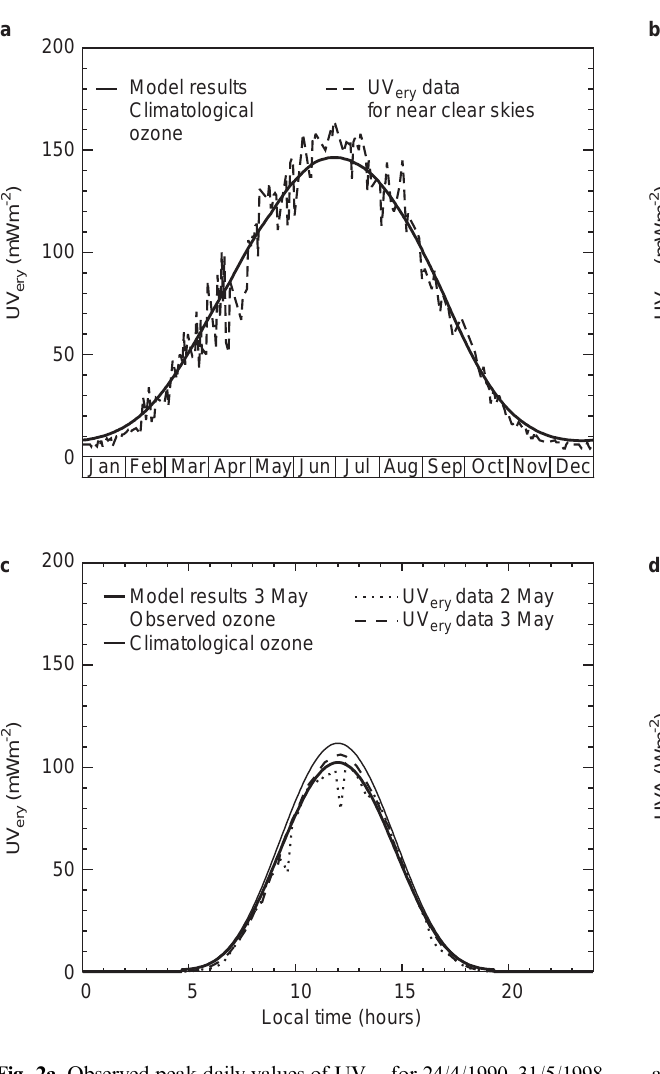
Fig. 2a. Observed peak daily values of UV ery for 24/4/1990–31/5/1998 at Chilton, Oxfordshire (51 : 6 (cid:14) N, 1 : 3 (cid:14) W) ( broken line ), together with calculated noon values for clear skies ( solid line ). b UV ery data at Camborne (50 : 2 (cid:14) N, 5 : 3 (cid:14) W) for 30/4/97 to 2/5/97 ( broken lines ) together with calculated values for 1 May ( solid lines ). Upper solid curve : calculated values assuming the observed total ozone value of 271 DU measured at Camborne. Lower solid curve : calculated values